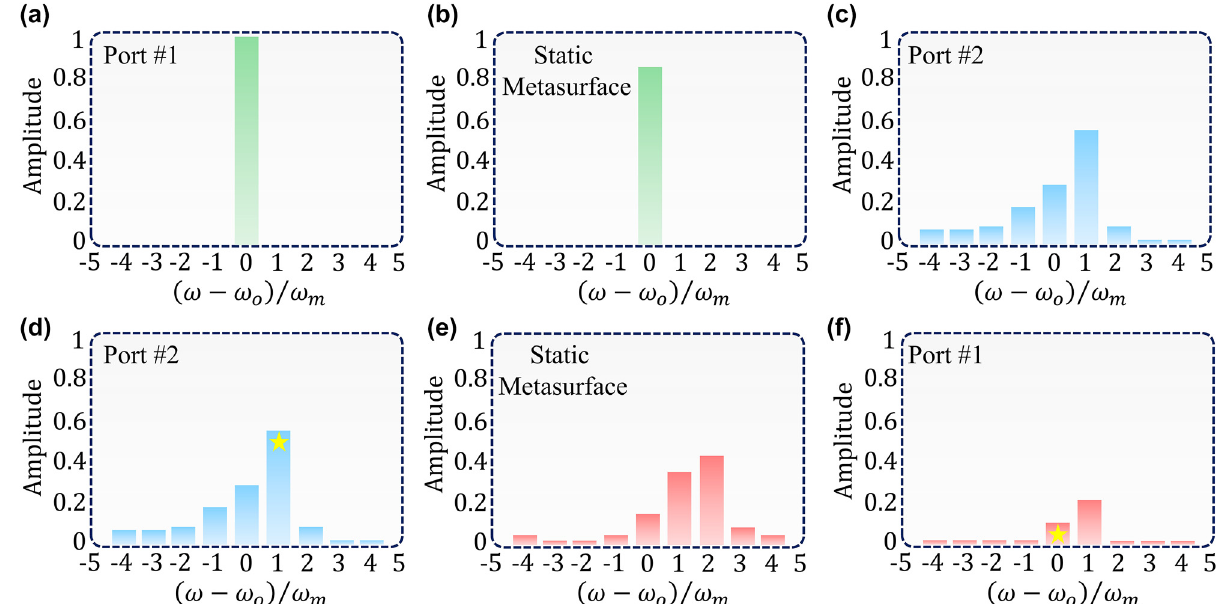
Figure 5: The nonreciprocal performance of the presented configuration. The spectral evolution of the (a) incident (b) transmitted signal prior to and after its interaction with the static layer. It is clear that while the signal amplitude slightly decreases, its spectral information remains untouched (c, d) the calculated output frequency spectrum of the signal after interacting with the time-modulated platform. In this case, both the amplitude and spectral content of the light will be manipulated. (e) The derived spectral information of the light after passing through the time-modulated metasurface in the time-reversal scenario. Owing to the second temporal photonic transition, the spectral distribution of the light will be changed once again. (f) The output spectrum of the signal that reaches the first port. On account of the special design of the static layer and its filtering behavior, the components of the light whose frequencies fall within the range of 𝜔 𝜔 ± 2 𝜔 , will be totally reflected, leaving a negligible amount of signal to reach to the first port. m o ( ) ∕ f ≈ 10 − 4 . The output frequency spectrum of f m o